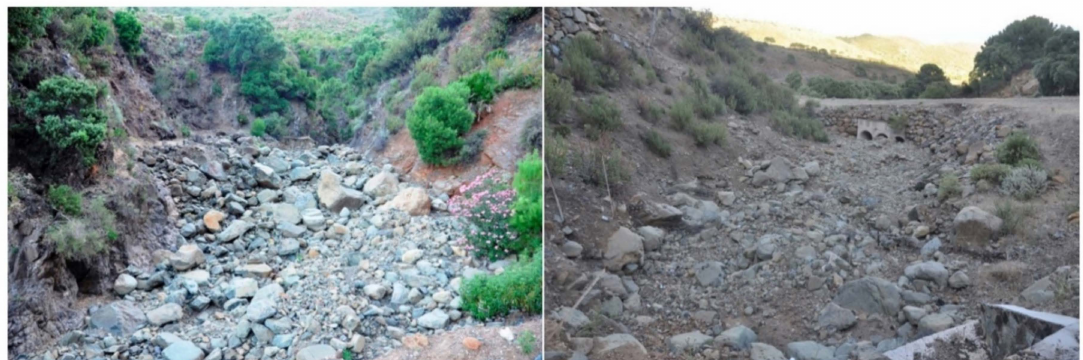
Figure 4. Examples of the addition of heterometric sediments to the channel from the slopes in the Cala river basin. The left picture shows rocks that have fallen directly on the riverbed, and the right picture shows the problem that they generate when they are dragged to a bridge on the Cala river.